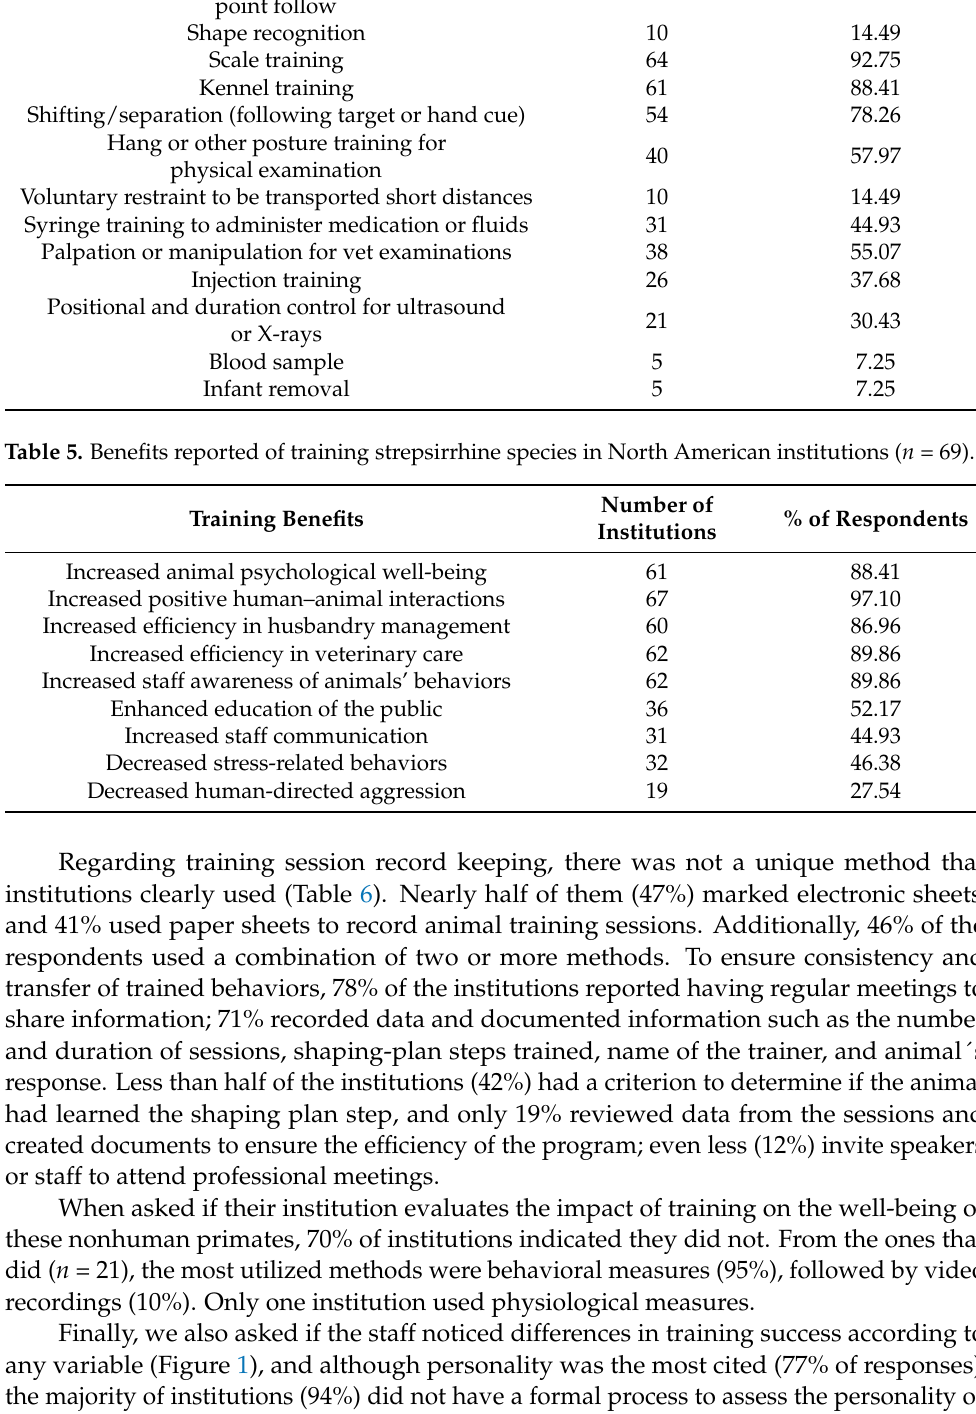
Number of Institutions